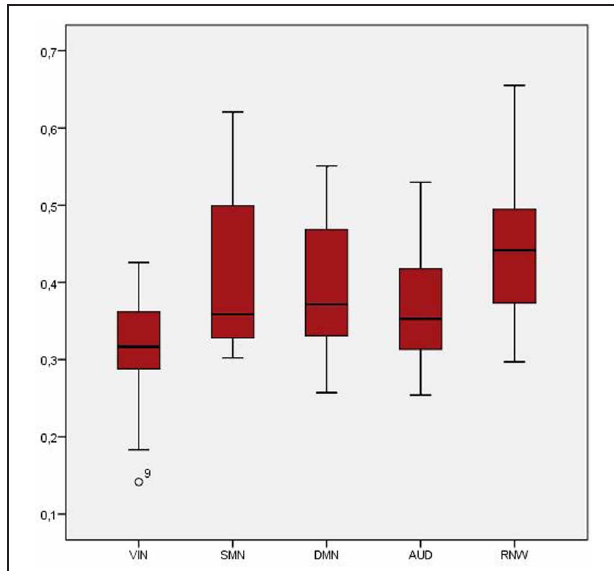
FIGURE 3 | Boxplot of overlap across all four conditions at the single-subject level.